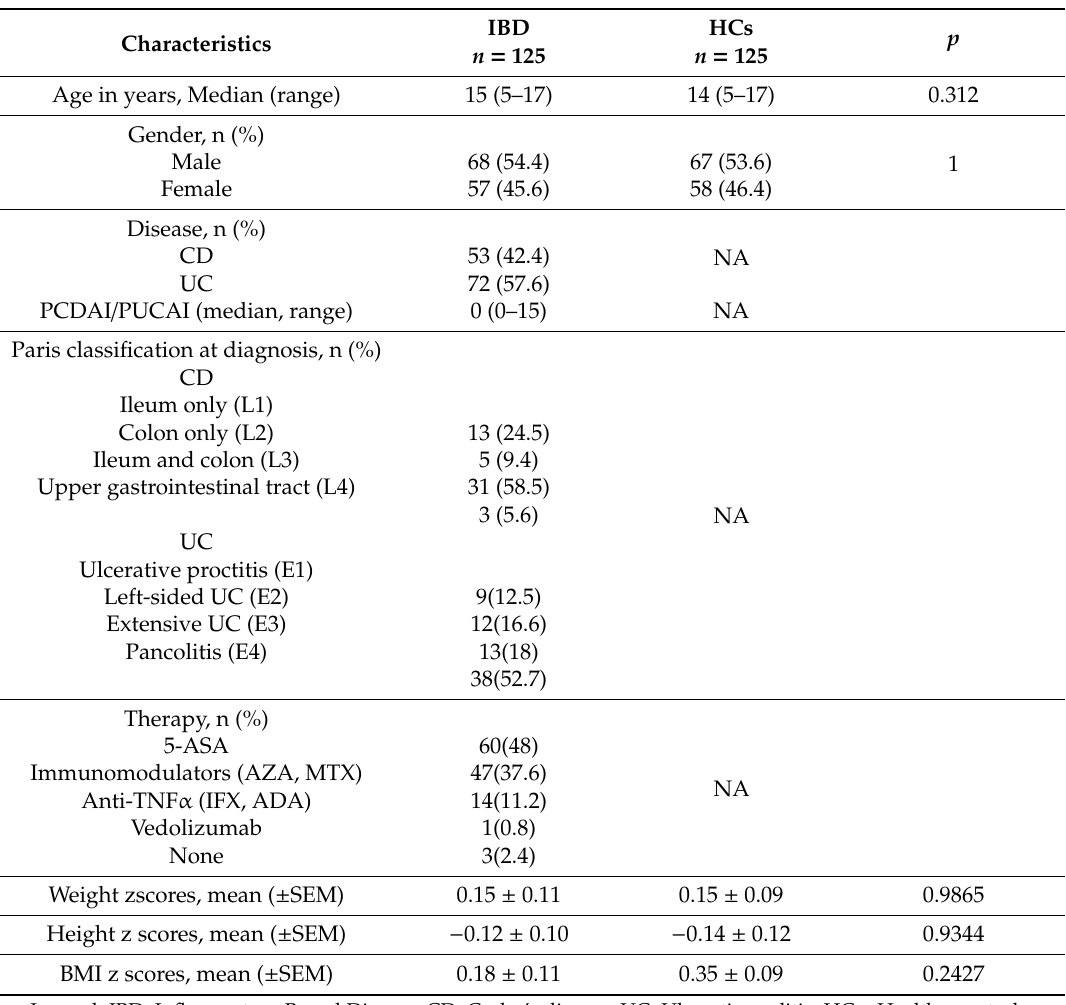
Table 1. Characteristics of 125 inflammatory bowel disease (IBD) patients enrolled and 125 healthy controls